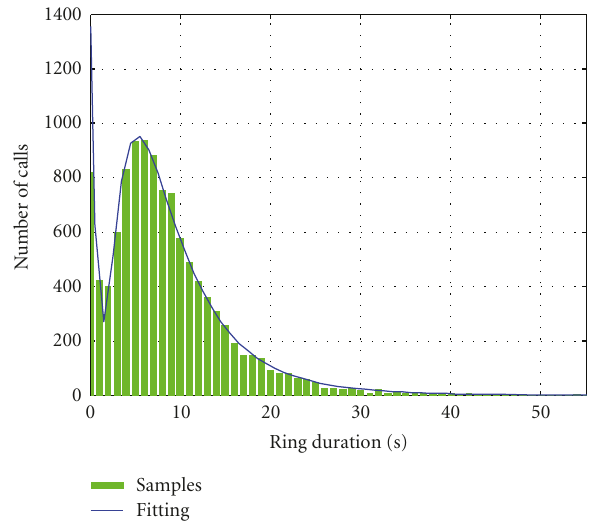
Figure 9: Fitting of ringing duration with a mix of exponential and lognormal pdf (cluster 1 observed for 4